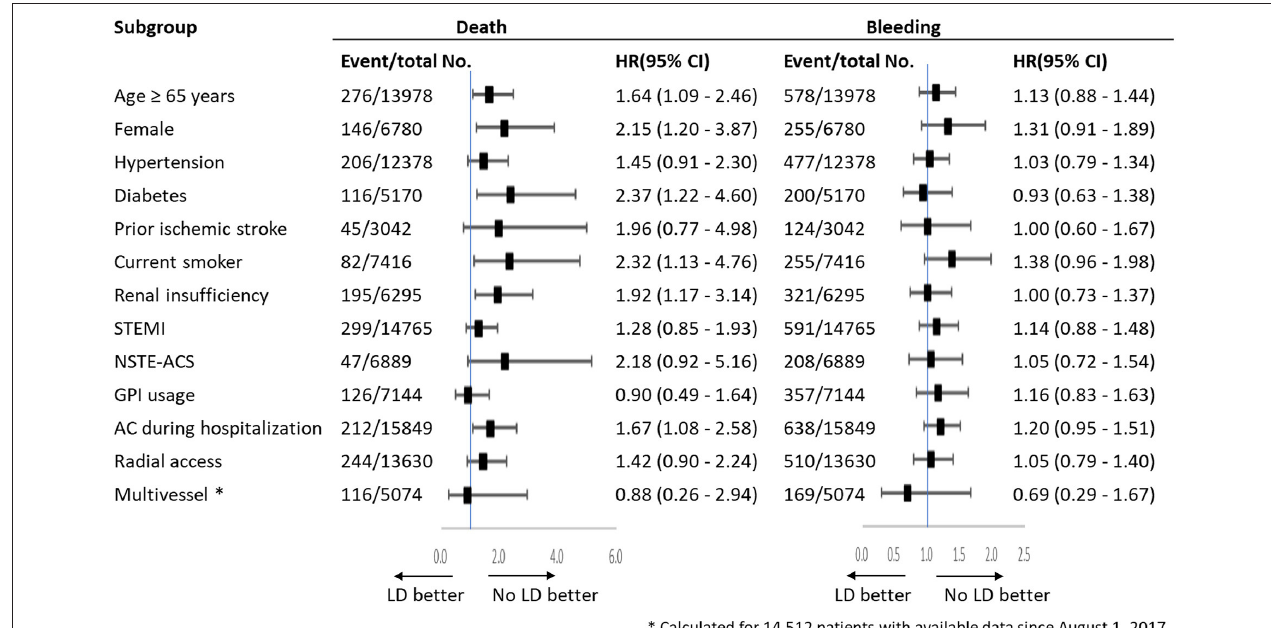
FIGURE 3 | Subgroup